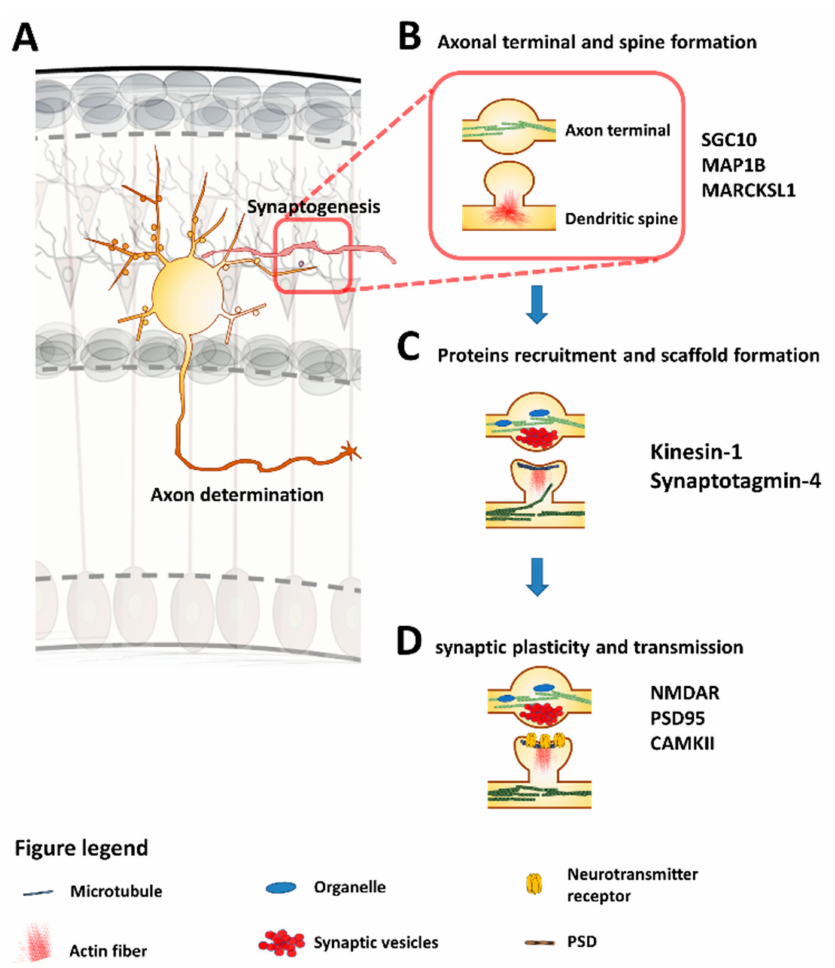
Figure 6. Synaptogenesis is controlled by JNK1. ( A ) Synaptogenesis occurs during neuronal di ff erentiation. ( B ) The presynaptic (axon terminal) and postsynaptic domains (spine formation) are formed through the regulation of SGC10, MAP1B and MARCKSL1 substrates by JNK1. These events regulate actin (red) and microtubule dynamics (green). ( C ) Kinesin 1, together with JNK and JIP, control vesicle and organelle transport (blue), e.g., the formation of postsynaptic density sca ff old proteins (black). ( D ) During synaptic transmission, the morphology of structures changes under the control of JNK1 (synaptic